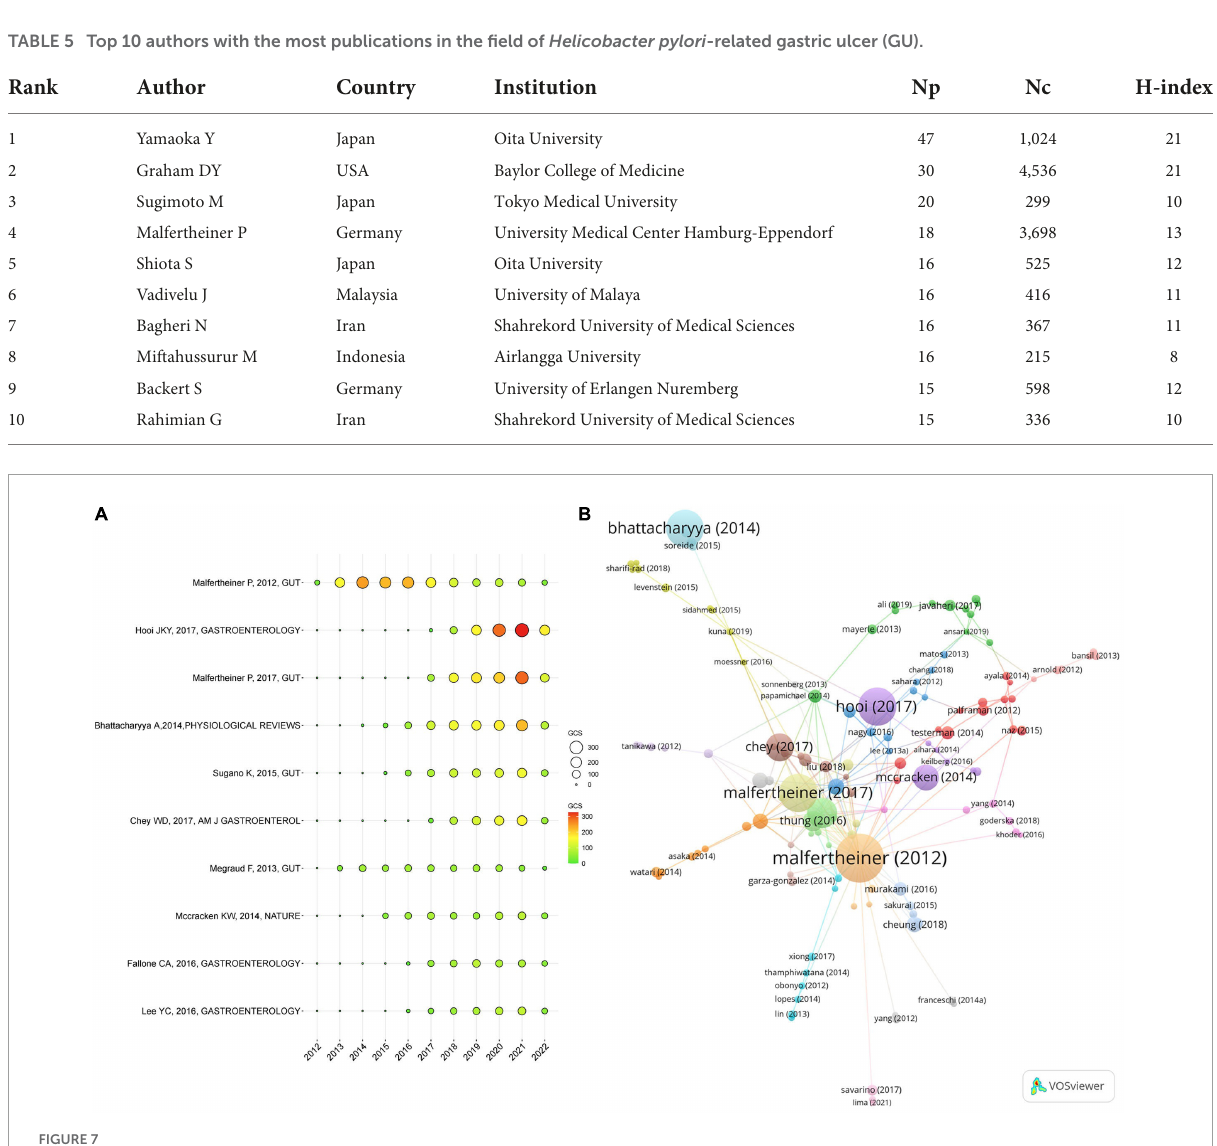
FIGURE7 Citations for the references. (A) The top 10 cited papers in GCS. (B) The network map of the document